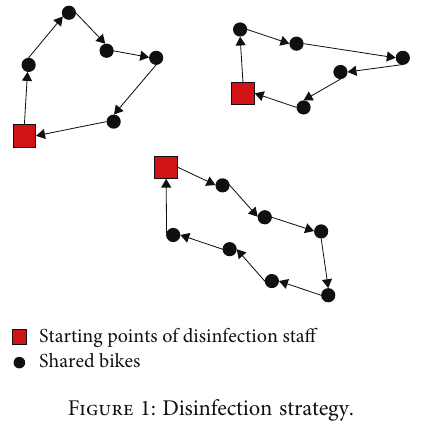
Figure 1: Disinfection